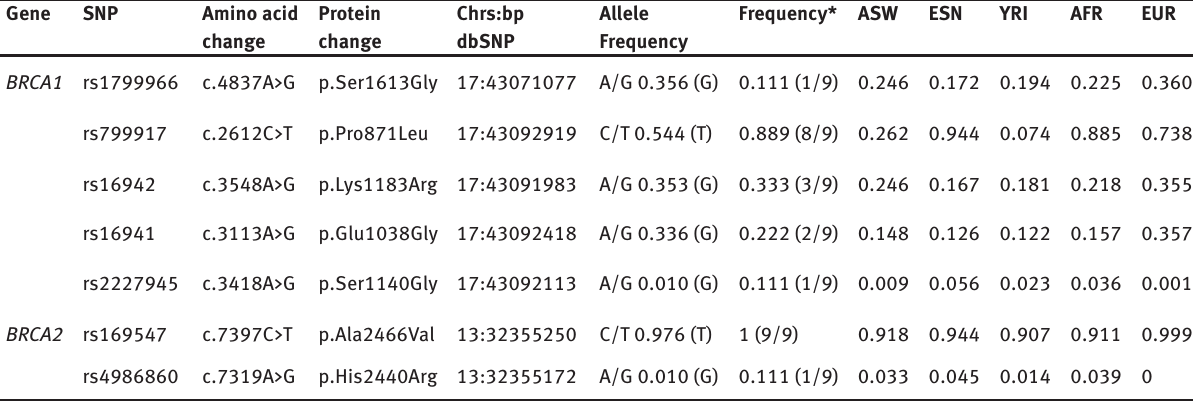
Table 2: List of known BRCA1 SNPs identified in this study and minor allele frequencies compared with other populations. Gene SNP Amino acid Protein Chrs:bp Allele Frequency* ASW ESN AFR change change dbSNP Frequency